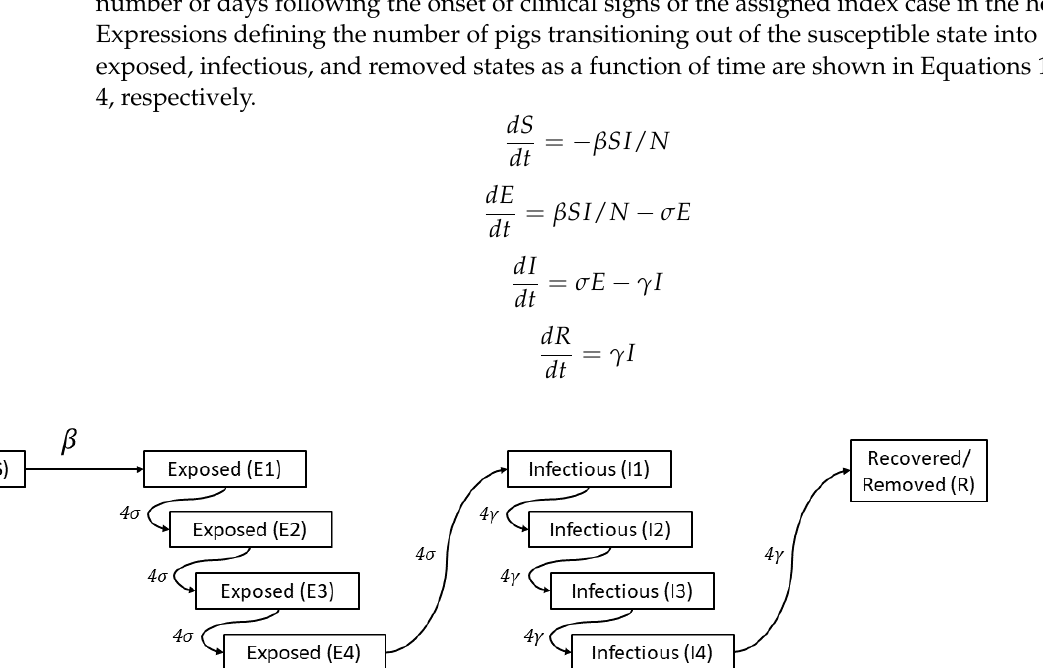
Figure 1. Schematic diagram of the susceptible-exposed-infectious-removed (SEIR) model described in the text. Sojourn times in the exposed I and infectious (I) states were split into 4 sub-compartments, effectively following Erlang distributions with shape parameter k = 4.